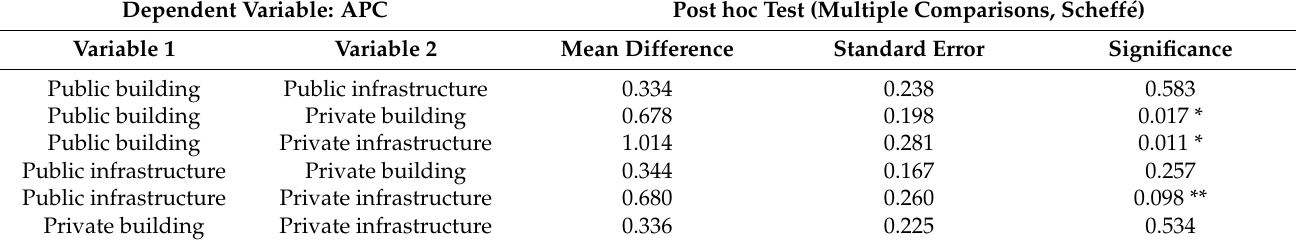
Table 13. Post hoc test outcomes.